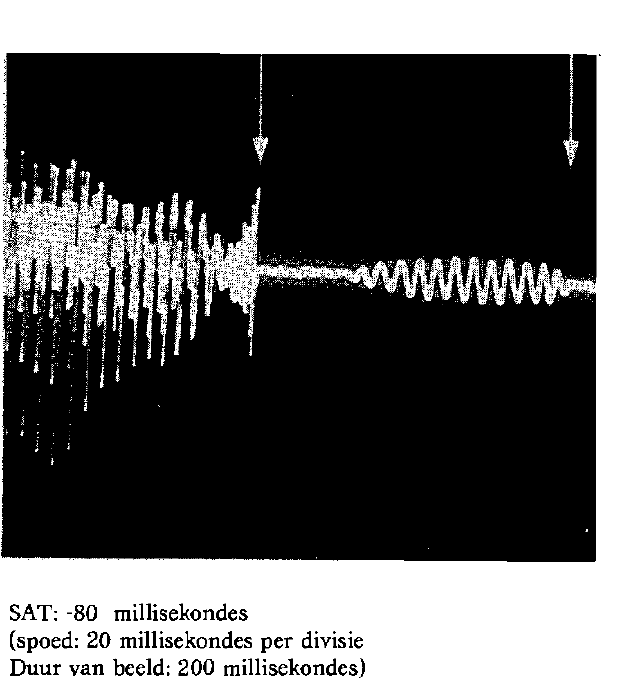
(spoed: 20 millisekondes per divisie Duur van beeld: 200 millisekondes) Figuur 2: Voorbeeld van 'n negatiewe stemaanvangstyd by 'n normale spreker.